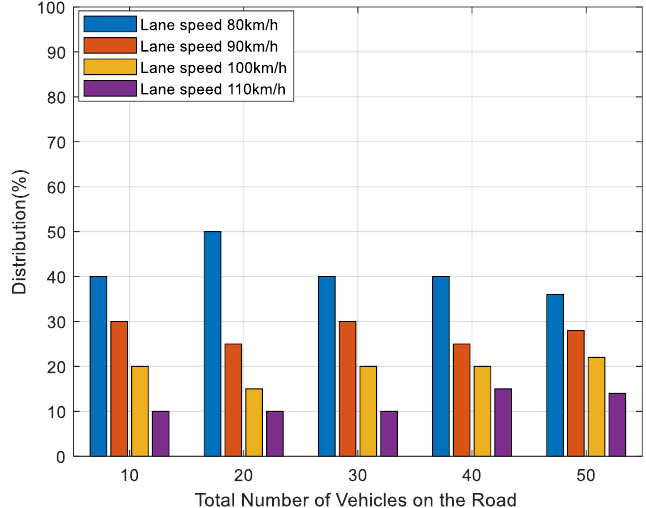
Figure 9. Percentage of distribution of vehicles.